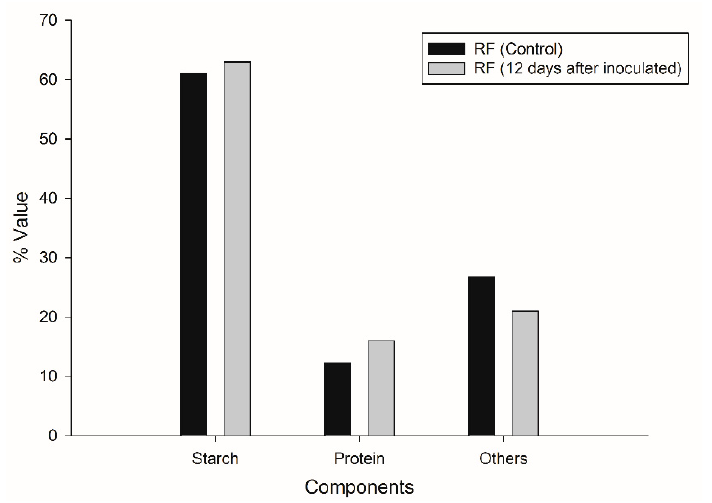
Figure 5. Comparative analyses of the principal components of the initial ramon flour (RF control) and the residual ramon flour (RF 12 days).